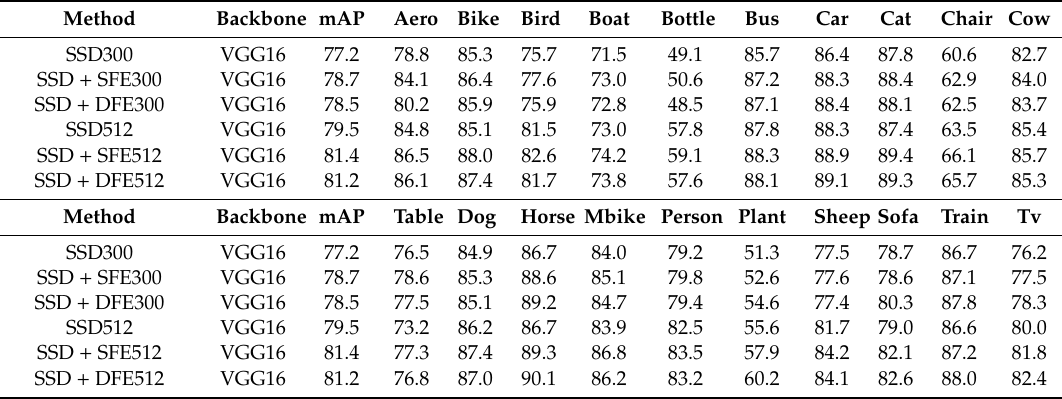
Table 3. Test results of SSD, SSD + SFE, and SSD +